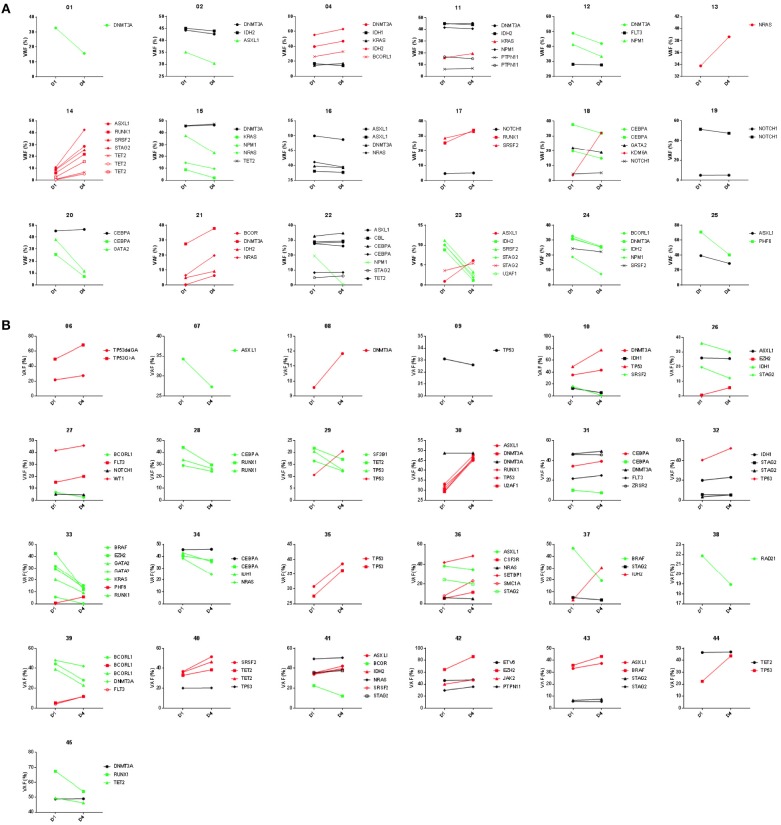
Variant frequency kinetics in blood from day 1 to 4 of AML chemotherapy. Results of targeted DNA sequencing on paired day 1 and 4 samples shown for 18 patients achieving complete remission (A) and 25 patients not responding (B) after induction chemotherapy. Trendlines highlight variants increasing (red) or decreasing (green) during induction therapy.